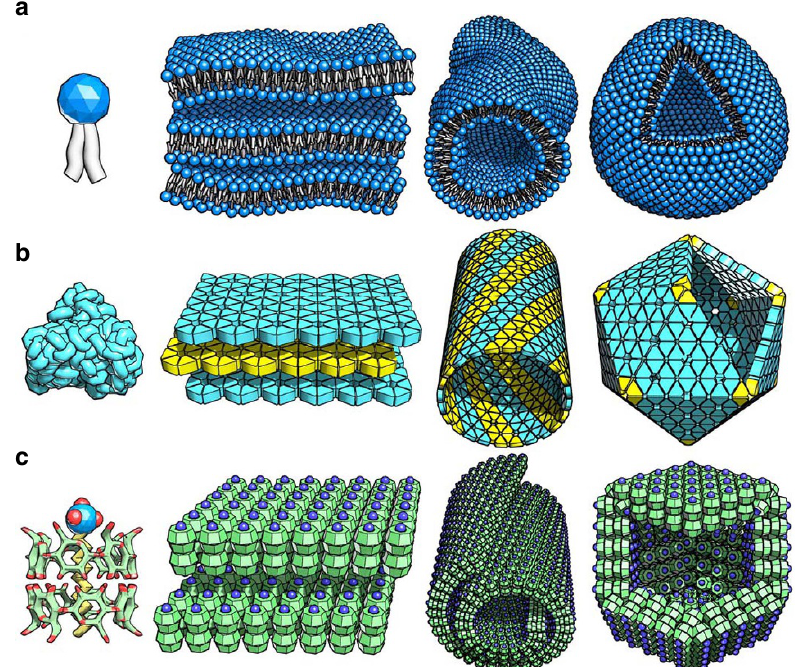
Figure 1 | Stylized view of the lipid-like and protein-like self-assembly. ( a ) Lipid molecules form lamellar, tubular and vesicular structures, the flexibility and fluidity of which are emphasized in the illustration. ( b ) Proteins form lamellar, helical tubular and regular icosahedral structures with rigidity and crystallinity (hexagonal lattice in this case). ( c ) SDS@2 b -CD assembles, in a protein-mimetic way, into lamellar, helical tubular and rhombic dodecahedral structures with inherent rigidity and in-plane, rhombic crystalline nature. In the molecular view, SDS is a anionic surfactant with a hydrocarbon tail (yellow) and a -(SO 4 ) (cid:2) headgroup (blue and red), while b -CD is a ring of hepta-saccharides (green C and red O